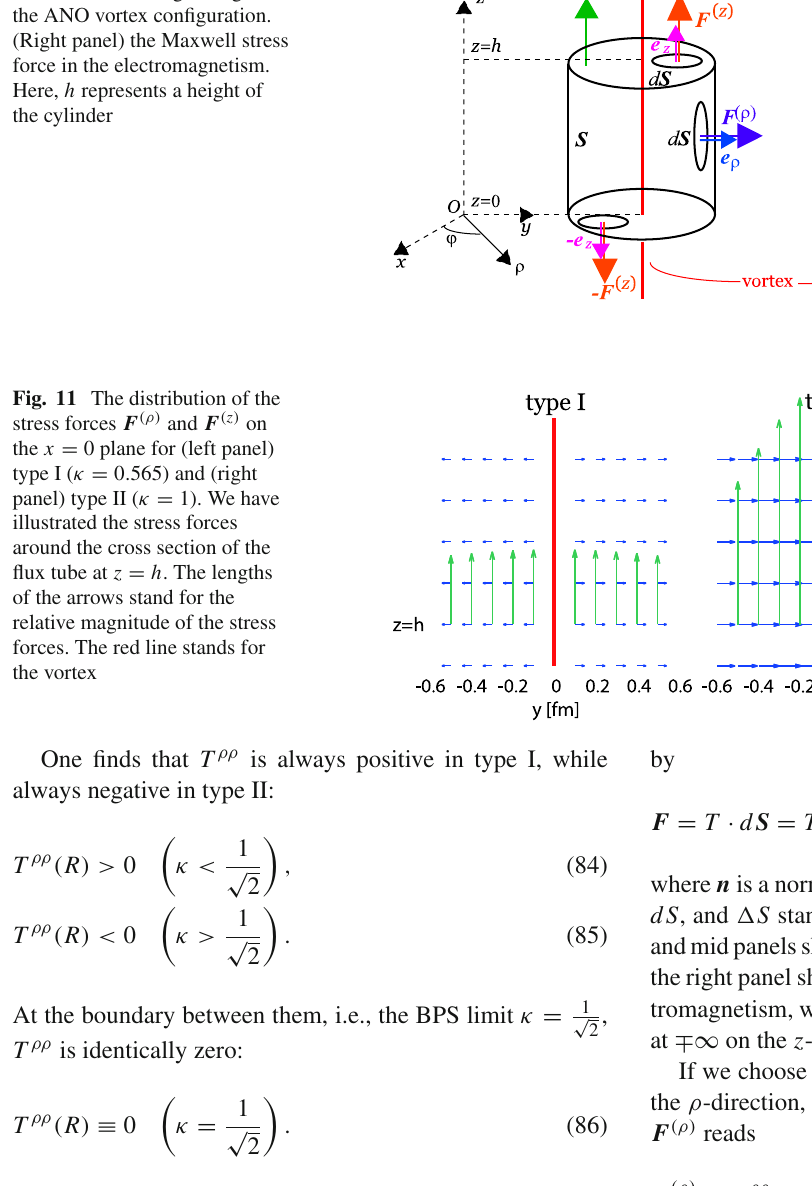
Fig. 10 (Left and mid panels) the Maxwell stress force acting on the flux tube originating from the ANO vortex configuration. (Right panel) the Maxwell stress force in the electromagnetism. Here, h represents a height of the cylinder